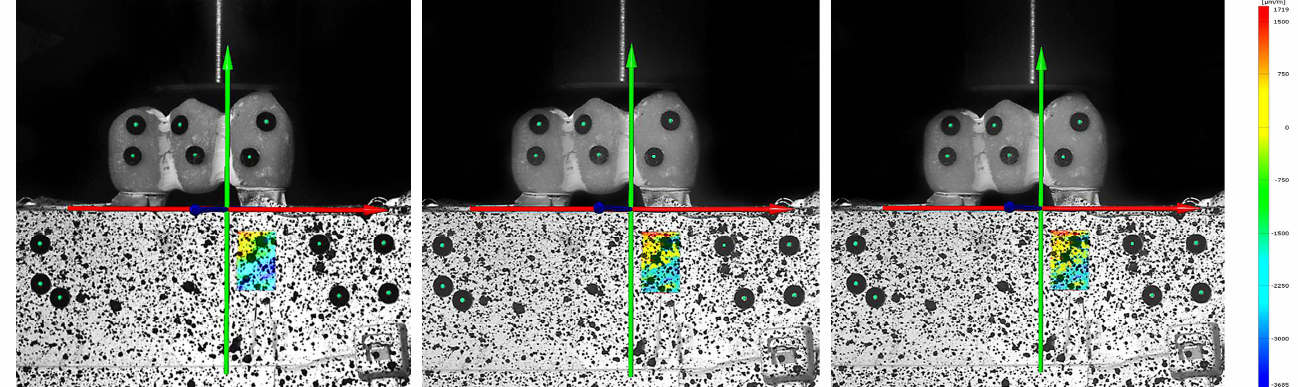
Figure 2. Experimental setup showing the frontal surface with superstructure as well as the optical measuring surface above strain gauge 1 at increasing mastocatory forces from left to right.